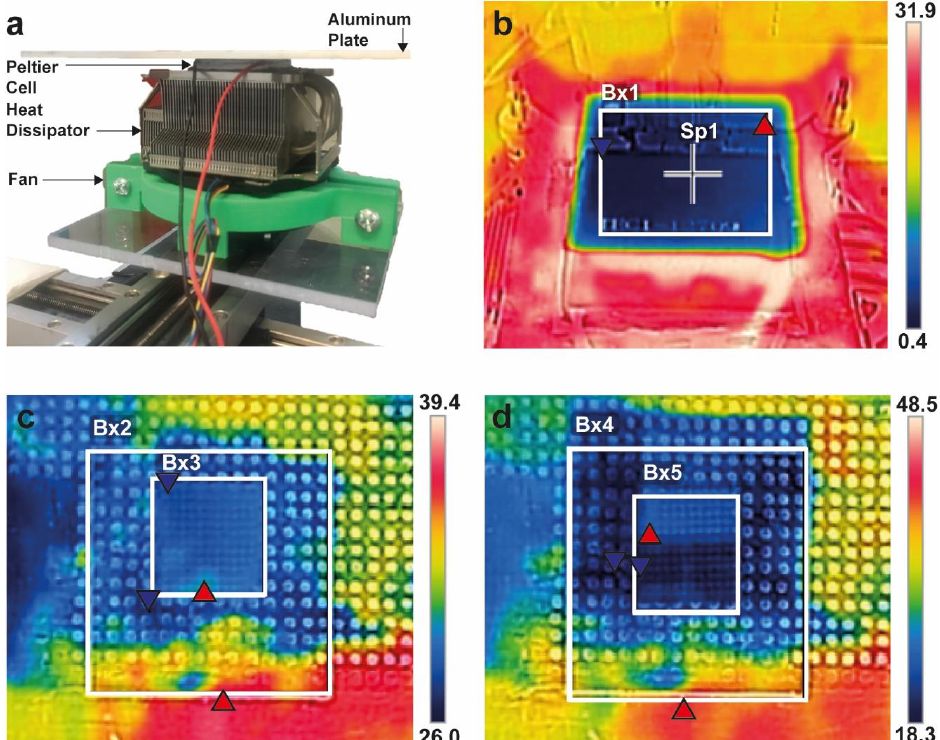
Figure 3. Temperature measurement analysis scheme (blue and red triangles indicate the lower and higher temperature zones inside the analyzed area). ( a ) Structure of the cooling system. It is composed of a Peltier cell controlled by Arduino, a heat sink, a fan, and an aluminum bed of 1 / 8 in., as the printing bed. ( b ) Peltier cell turned on. The local average temperature in zone Bx1 was 2.5 ◦ C and the point Sp1 registered 2.3 ◦ C. ( c ) SCF-NC printing. The temperature in the sca ff old area (Bx3 zone), with the cooling system, turned o ff was 27.5 ◦ C. ( d ) SCF-C printing. When the cooling system was turned on, the temperature in the sca ff old area (Bx5) decreased by 20%.